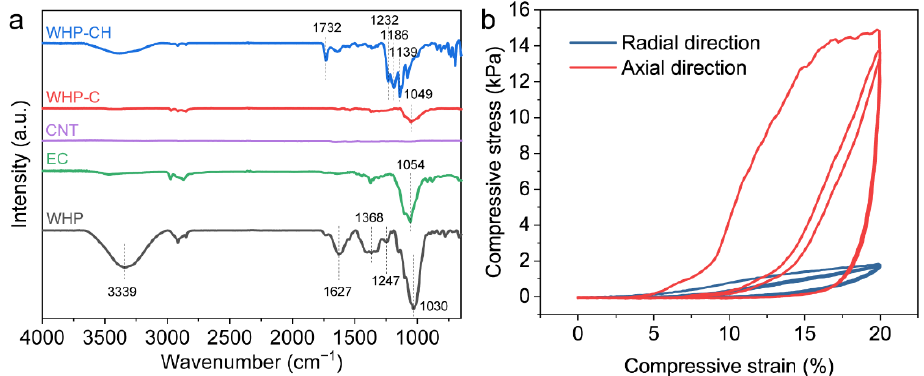
Figure 3. ( a ) FTIR spectra of WHP, EC, CNT, WHP-C, and WHP-CH. ( b ) Compressive stress–strain curves of WHP during loading–unloading cycles (3 times) in radial and axial direction, showing the anisotropic feature of WHP.